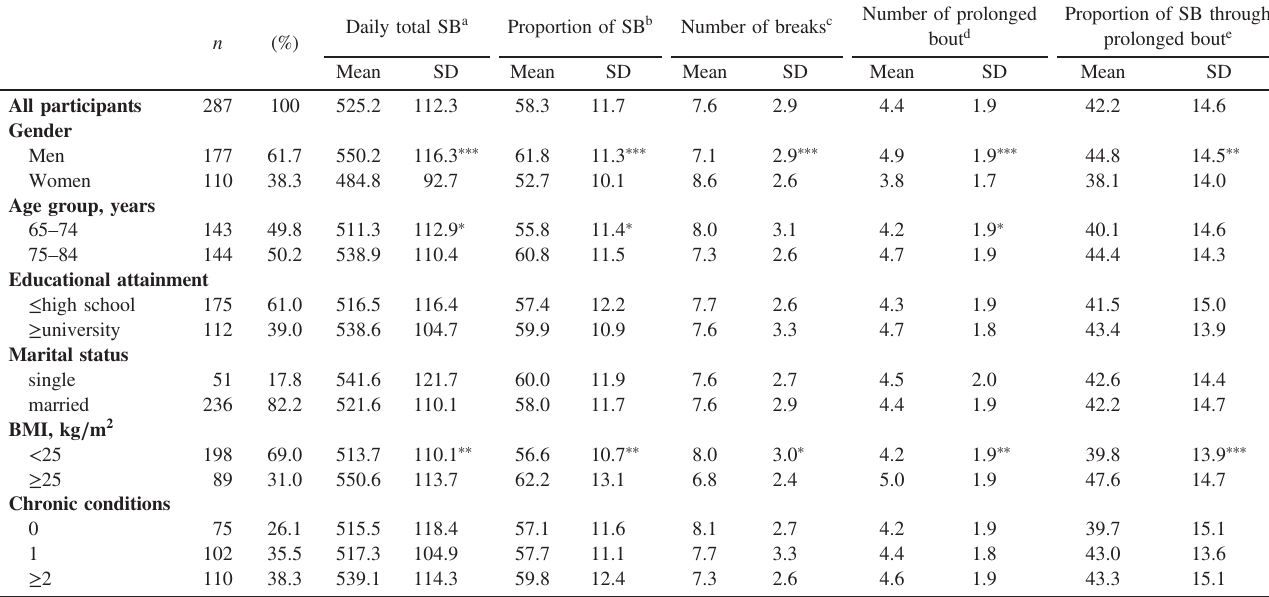
Table 1. Patterns of objectively-measured sedentary